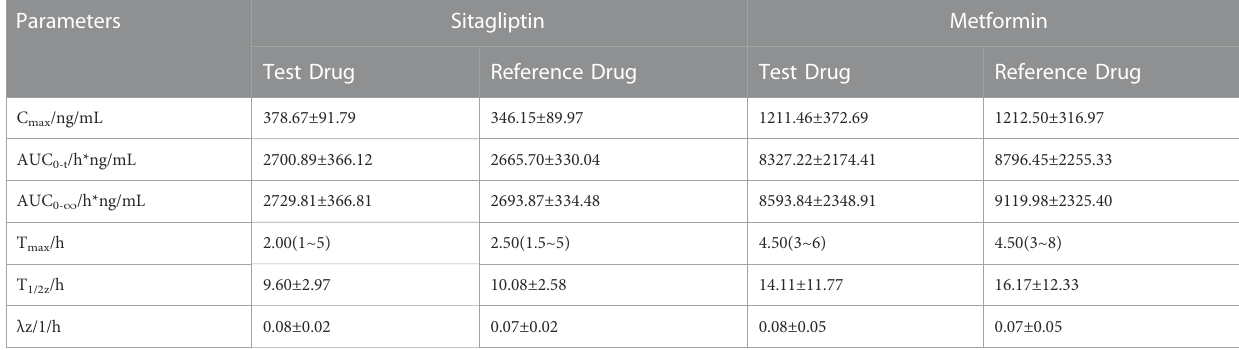
TABLE 2 Pharmacokinetic parameters after single-dose administration of test and reference drug under fasting state.